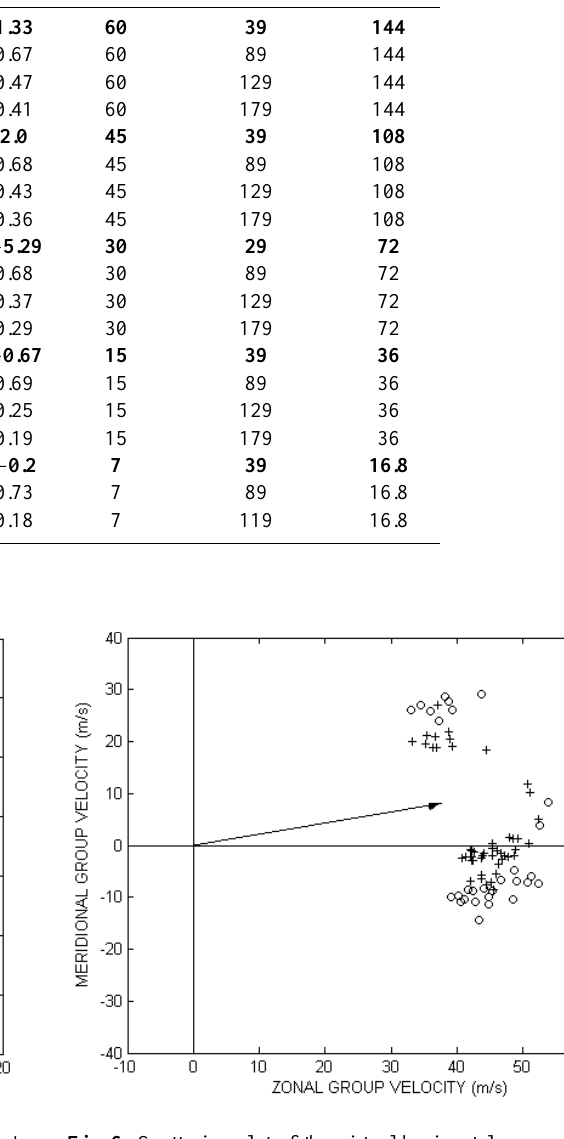
real, so only part of Figs. 4 and 5 can represent the “virtual group velocity distributions”. We need one more parameter to decide the true solution, and a possible parameter is